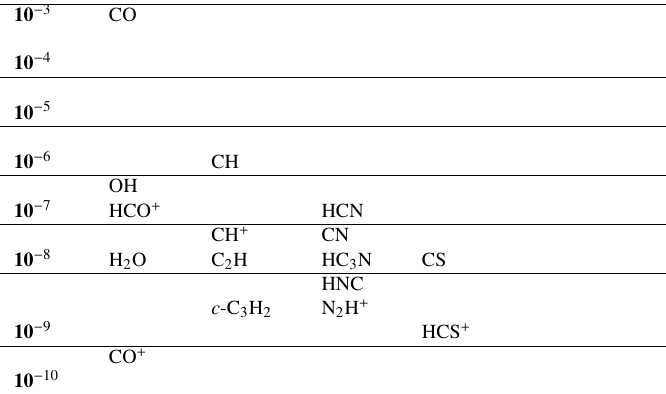
Table 3. The inventory of molecules detected in NGC 7027 (as of July 2022)